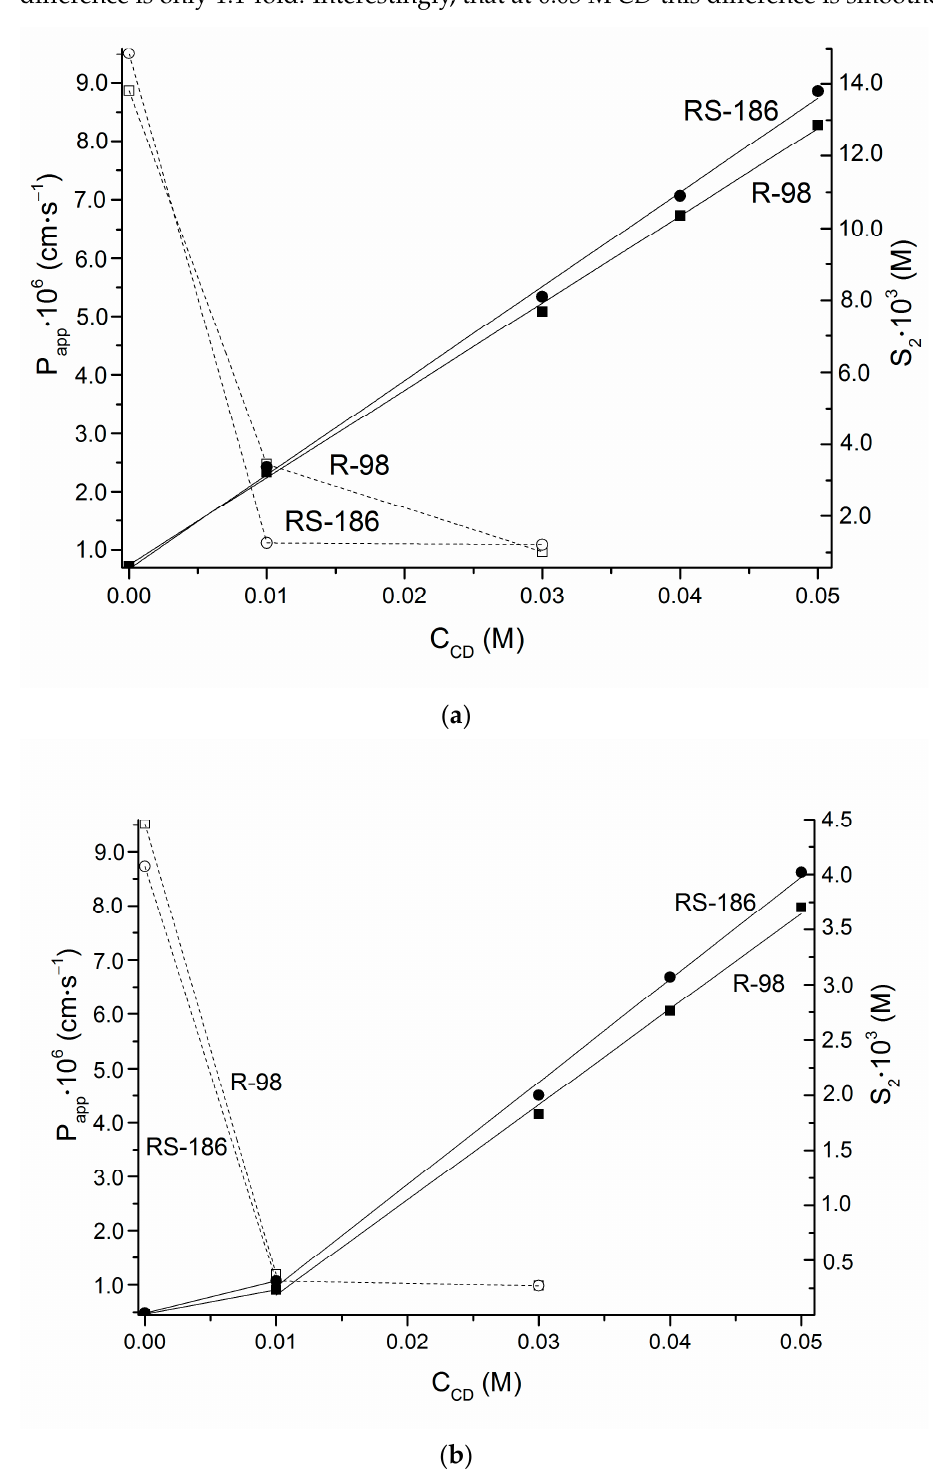
Figure 4. Solubility-permeability interrelation exemplified by the effect of CD concentration on R-98: apparent permeability coefficient—black opened squares— □ , solubility—black filled squares— ■ ; and R-186: permeability coefficient—black opened circles— ○ , solubility—black filled circles— ● . ( a ) pH 2.0; ( b ) pH 7.4. The solid and dashed lines indicate the solubility and permeability dependences, respectively.